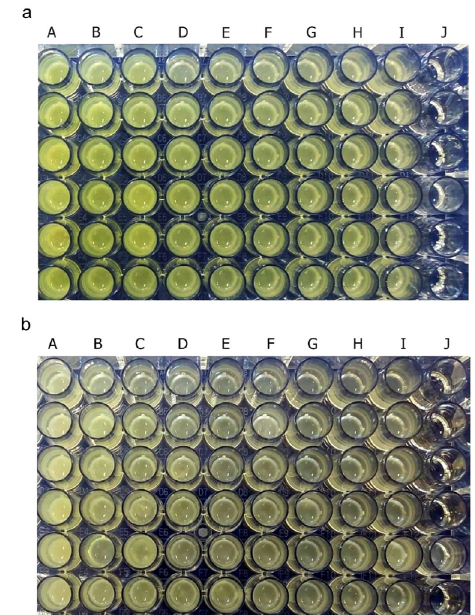
Figure 2. Pyocyanin was identified from the greenish colour of the P. aeruginosa culture supernatant after 36 h incubation at 37°C. P. aeruginosa bacteria (1.5 × 10 5 CFU/well) ATCC 10145 ( a ); clinical isolate ( b ). Royal jelly 12.5% (A); 6.25% (B); 3,125% (C); 1.56% (D); 0.78% (E); 0.39% (F); 0.19% (G); 0.098% (H); 0% (I); No treatment (J).